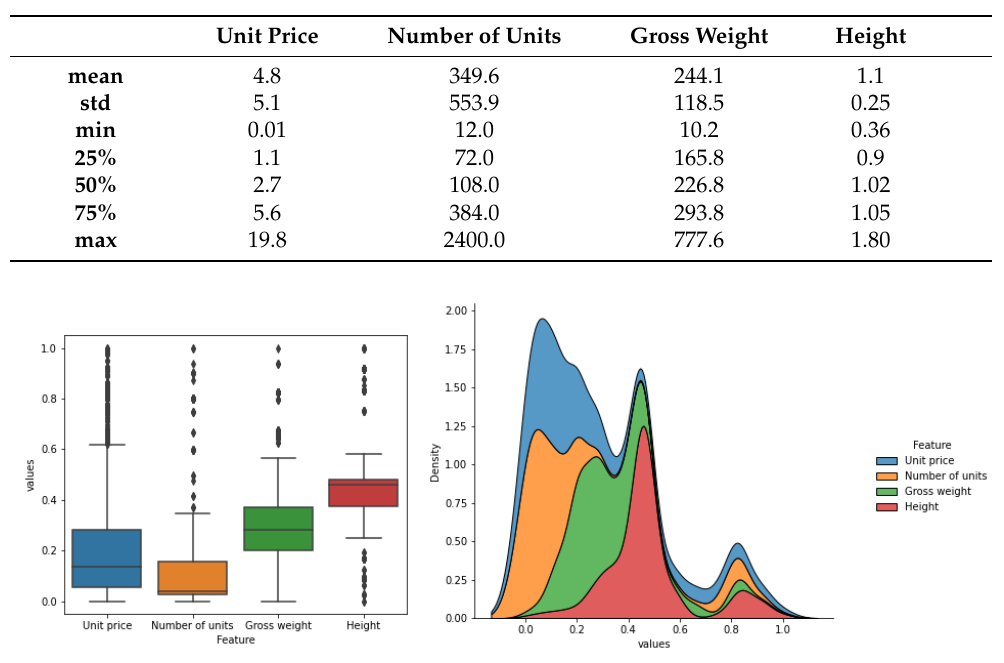
Figure 3. Box plots and kernel density estimation plots of the SKU features.